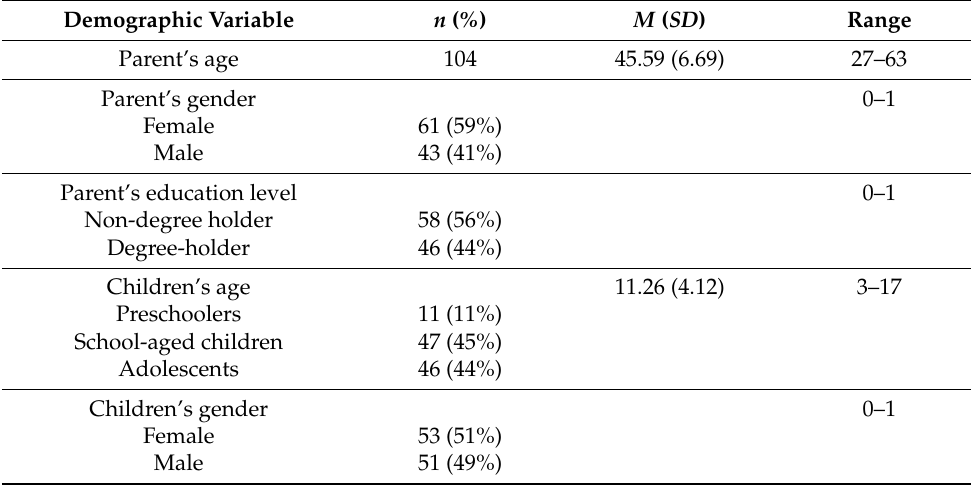
Table 2. Demographic characteristics of parent and child groups.